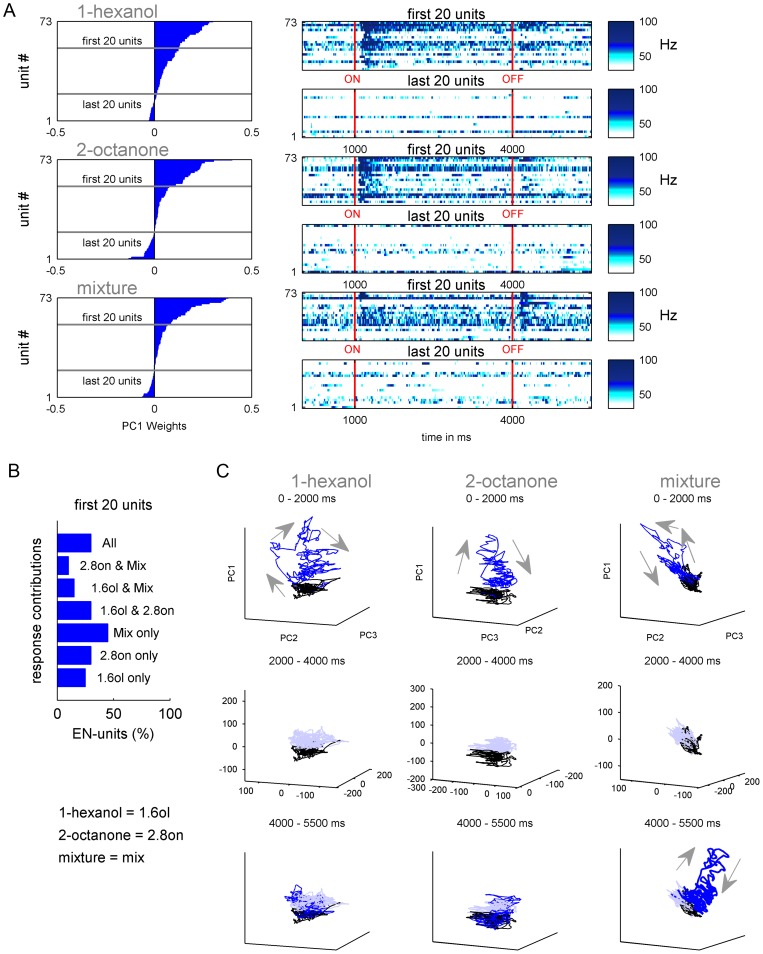
Principal Component Analysis (PCA) of the EN ensemble for each odor stimulus.(A) left: The weights of each unit (blue bars; N = 73) on the first principal component PC1 was used to order the units from positive (top) to negative weights (bottom). (A) right: The first and the last 20 EN-units were used to illustrate the features covered by PC1. Each line represent the false color coded IFR calculated out of the 10 repetitions per odor and unit. Stimulation is marked by red lines. PC1 contrasted odor sensitive and insensitive units. (B) In contrast to PNs (Figure 3), the response spectrum of the ENs is rather odor unspecific. Most of the 20 main contributing units were involved in the representation of at least two stimuli. For example from the 20 first main contributing units of 1-hexanol, 25% respond to 1-hexanol only, 30% to 1-hexanol and 2-octanone, 15% to 1-hexanol and the mixture, and 30% to all stimuli. The same tendency was shown by the first 20 main contributing units of 2-octanone. (C) The transients of the first three PCs (PC1, PC2 and PC3) were drawn. The column's separate the odors while the rows represent different time windows during stimulus presentation. Background activity of 1000 ms before odor onset is marked in black. The first row illustrates the first 1000 ms after odor onset (blue), during which time there is a rapid divergence from background to form a transient. In contrast to PNs there is no ‘fixed point’ dynamics during the following 2000 ms (second row, light blue). During the 1500 ms following the odor off set (third row, blue) the most drastic activity increase occurs for the mixture.